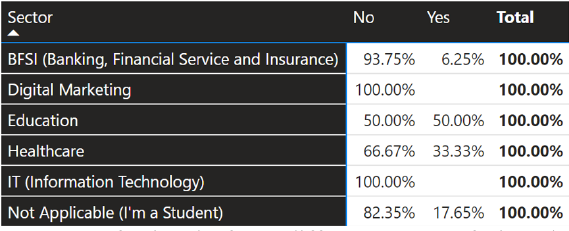
Fig. 5. Professionals from different sectors facing the financial crunch